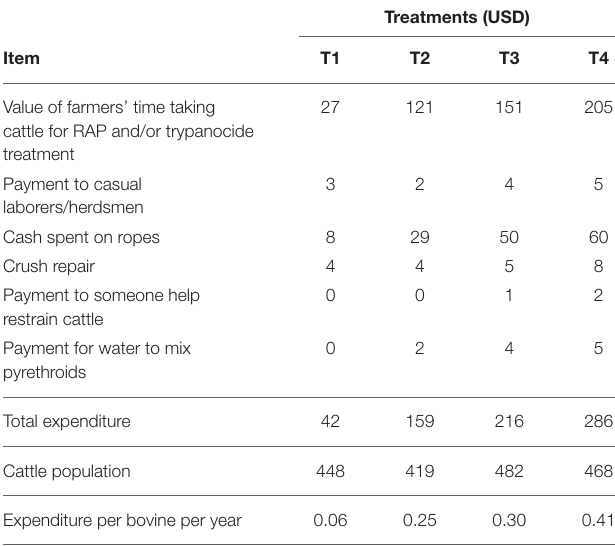
TABLE 5 | Livestock keepers’ expenditure on intervention related items over 18